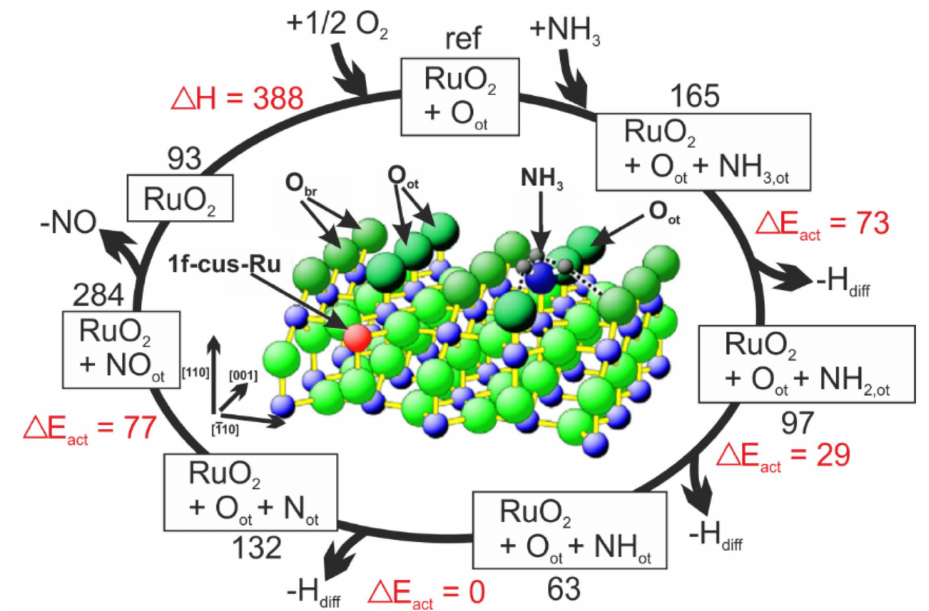
Figure 7. Microscopic reaction steps in NH 3 oxidation over RuO 2 (110). Activation energies (red) and total adsorption energies (black) are determined by DFT calculations and are given in kJ mol − 1 . -H diff means that abstracted H from NH x is removed from its direct neighborhood by diffusion along with various O species on the surface. Reprinted from [99] with permission from